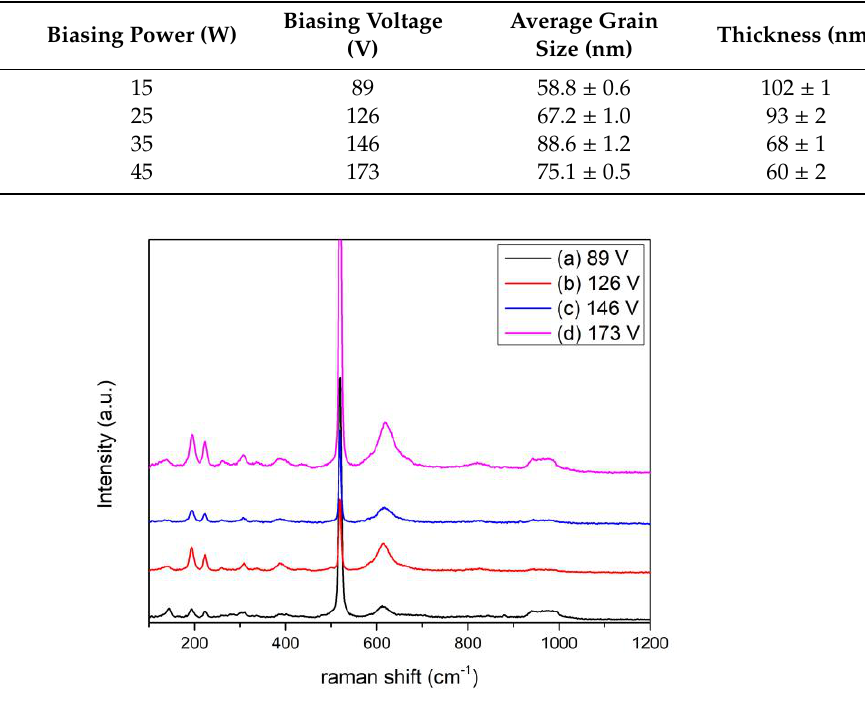
Figure 1. Raman spectra of the as-deposited VO 2 thin films with substrate biasing: ( a ) 89 V; ( b ) 126 V; ( c ) 146 V; ( d ) 173 V.